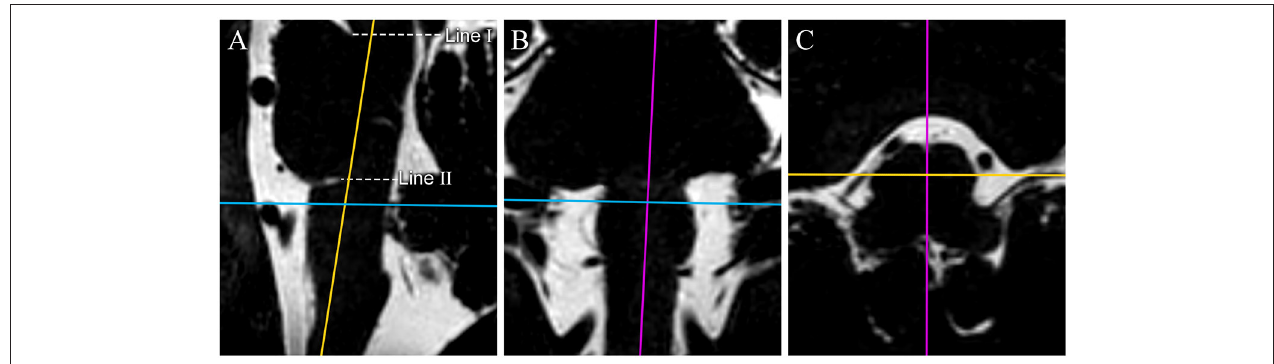
FIGURE 1 | The reconstruction process of original MR image data. 3D-T2-weighted images are reconstructed in the sagittal plane (A) , coronal plane (B) , and transverse plane (C) . Color lines represent corresponding planes (purple: sagittal plane, yellow: coronal plane, and blue: transverse plane). 3D-T2-weighted images are reconstructed to get the median sagittal plane (A) according the anterior median sulcus and posterior median fissure of the medulla oblongata in the transverse plane image (the purple line on C ) and the long axis of the medulla oblongata on the coronal plane image (the purple line on B ). Line I passes through the superior pontine notch and the inferior edge of the quadrigeminal plate. Line II runs parallel to line I, passes through the inferior pontine notch, and is considered the pontomedullary sulcus. We made a hypothesis in the study: through our adjustment of the plane, the pontomedullary sulcus we confirmed by line II could be on the same horizontal plane. The transverse images are reconstructed based on the auxiliary line on the median sagittal plane image for surveying the CN IX-X